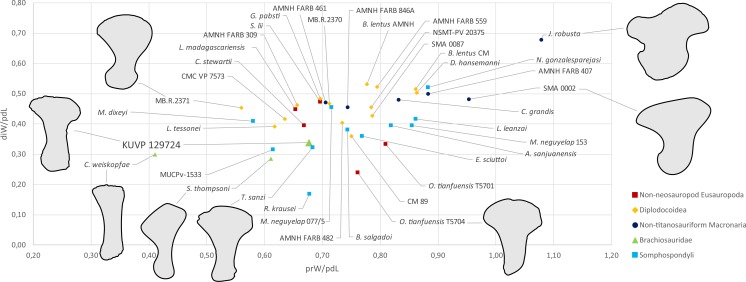
Shape differences in sauropod metatarsals V.The graph represents morphospace occupation of sauropod mt V when comparing proximal transverse widths (prW; x-axis) and distal transverse widths (diW; y-axis) with proximodistal length (pdL). The left mt V of KUVP 129724 is within the morphospace occupied by titanosauriform sauropods (Brachiosauridae + Somphospondyli), and clearly outside non-titanosauriform macronarians like Camarasaurus and Janenschia. Measurements and sources are provided as Table S1. Outlines of selected specimens are traced from the following publications: Janenschia robusta SMNS 12144 (right reversed) from a photo taken by J Nair in 2014, Camarasaurus sp. SMA 0002 (right reversed) from Tschopp et al. (2015), Omeisaurus tianfuensis ZDM T5704 (left) from He, Li & Cai, 1988, Tastavinsaurus sanzi MPZ 99/9 (right reversed); traced from Canudo, Royo-Torres & Cuenca-Bescós (2008), Sonorasaurus thompsoni ASDM 500 (right reversed) from D’Emic, Foreman & Jud (2016), Cedarosaurus weiskopfae DMNH 39045 (right reversed) from D’Emic (2013), and the indeterminate diplodocid MB.R.2371 (left) from a photo taken by E Tschopp in 2014. The metatarsals are scaled to equal proximodistal length to highlight shape differences.